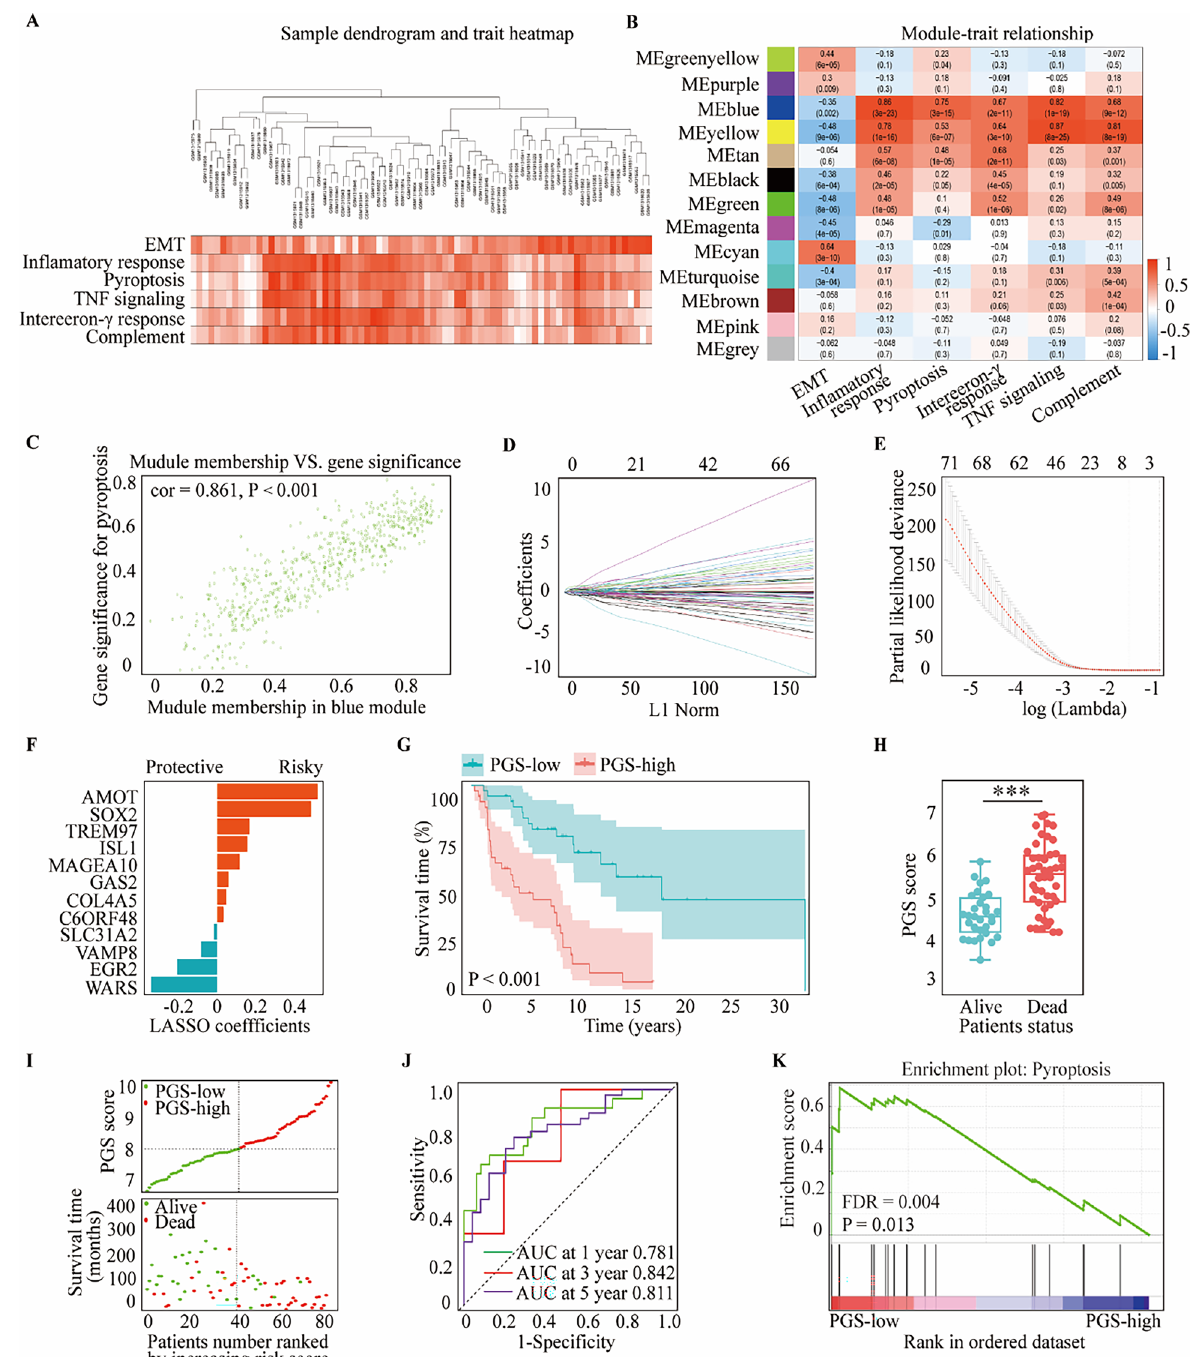
Figure 2. Construction of the PGS using the melanoma cases in the GSE54467 dataset. ( A ) Clustering dendrogram of the 77 samples using WGCNA. ( B ) Heatmap of the interrelation between cancer hallmarks and the modules. ( C ) Interrelation between the blue module and pyroptosis. ( D ) LASSO coefficient results for the relationship between pyroptosis-related differentially expressed genes and melanoma prognosis. ( E ) Penalty parameter λ selection via tenfold cross-validation in the LASSO model. ( F ) 12 pyroptosis-related genes determined from LASSO coefficients. ( G ) Kaplan–Meier OS curves for patients in the PGS-low and -high groups. ( H ) Comparison of PGS scores in living and dead patients. ( I ) Distribution of PGS scores, patient status and OS periods. ( J ) Time-dependent ROC curves at 1, 3 and 5 years. ( K ) GSEA of the pyroptosis pathway in the PGS-low and -high groups. Statistical analysis: *** p < 0.001. This figure was created using R software version 4.0.3 (https:// www.r- proje ct. org/) and GSEA software 4.2.1 (https:// www. gsea- msigdb. org/ gsea/ index. jsp) 33